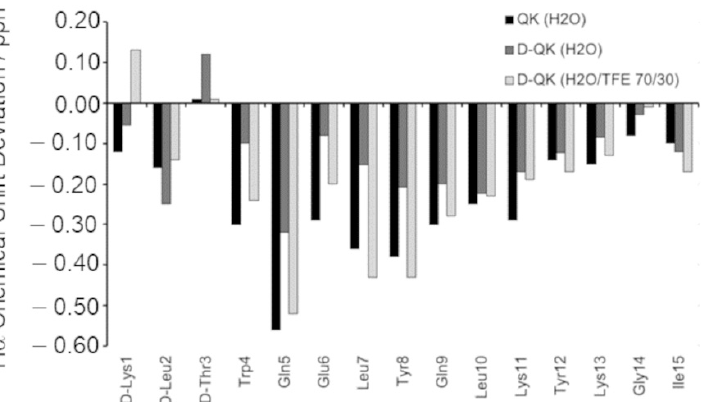
Figure 2. Experimental secondary chemical shifts from the H α protons of QK (in H 2 O), D-QK (in H 2 O) and D-QK (H 2 O/TFE 70/30 v/v ).